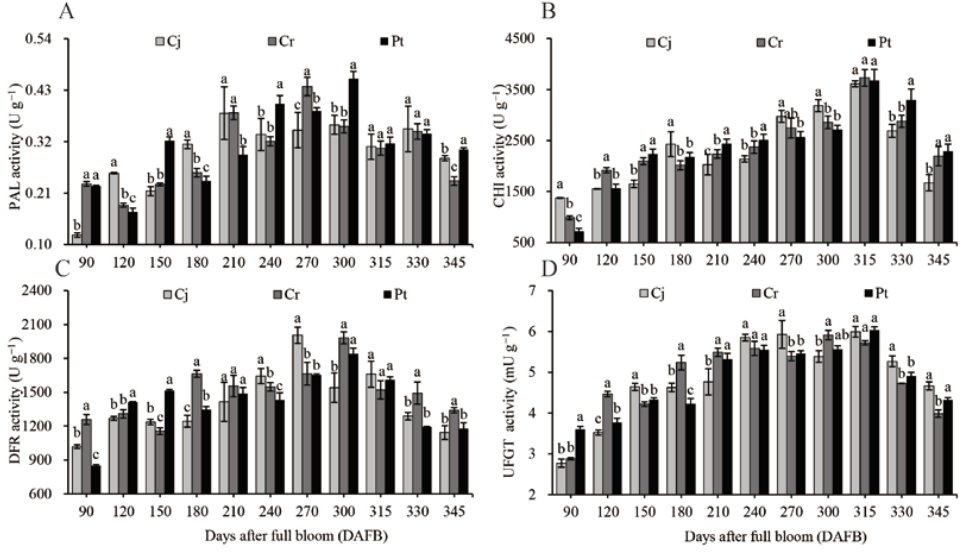
Figure 6. Dynamic changes in ( A ) PAL, ( B ) CHI, ( C ) DFR, and ( D ) UFGT enzyme activities of blood oranges grafted onto different rootstocks during fruit development and ripening.